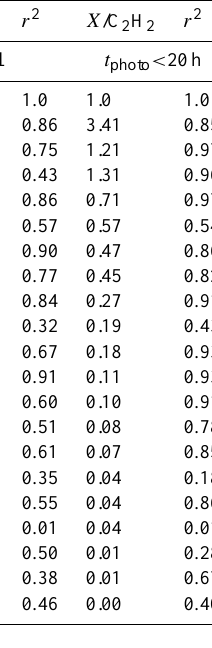
Table 3. Emission ratios for selected volatile organic compounds with respect to acetylene measured and associated coefficient of variation for all EM25 samples and for the subset with photochem- ical age less than 20 hours. Atmospheric lifetimes with respect to oxidation by OH at a concentration of 2 × 10 6 moleculescm − 3 re- ported by Atkinson (2000) are listed for selected